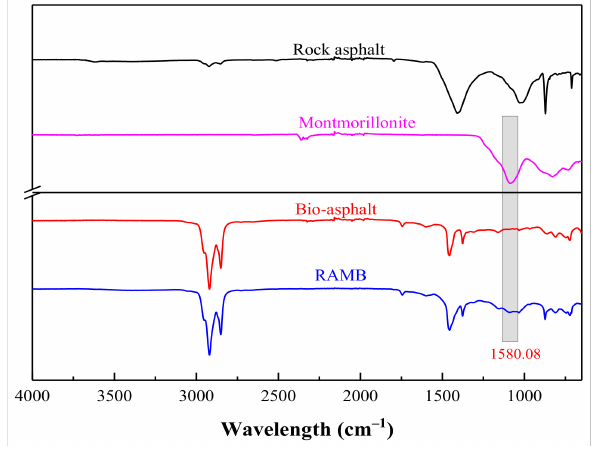
Figure 20. Infrared spectroscopy of rock asphalt, montmorillonite, bio-asphalt and